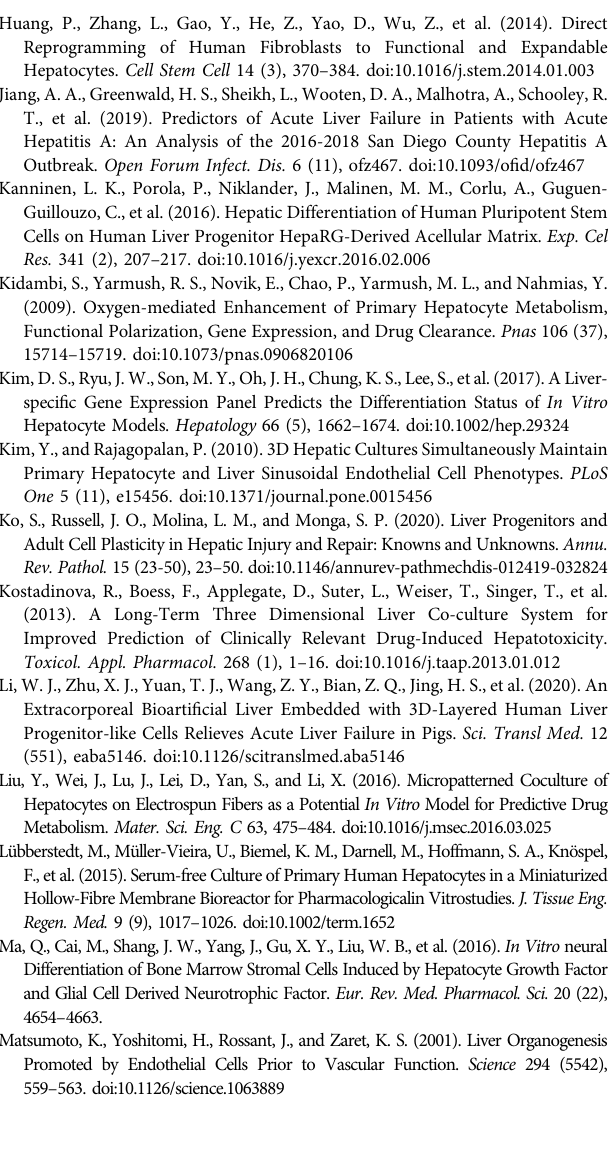
Supplementary Figure S1 | The safety and ef fi cacy of HepLPCs expressing HSV-TK. (A) GCV had a signi fi cant inhibitory effect on HepLPCs. Data are normalized to the DMSO group. (B) Cells appeared died after GCV treatment. (C) The Calcein-AM/PI assay was performed after GCV treated for 48h. (D) The PI positive cells were calculated from three independent experiments. Data are normalized to the DMSO group. (E) Cells were inoculated subcutaneously in immunode fi cient mice, n (cid:2) 5. (F) The cell viability (GFP positive cells) was calculated from three independent experiments. Data are normalized to the DMSO group. (G) The TUNEL assay was performed after GCV treatment. (H) The apoptotic cells (TUNEL staining positive cells) were calculated from three independent experiments. Data are normalized to the DMSO group. Data are represented as means ± SEM. * p < 0.05 and ** p < 0.01. Scale bars: 100 μ m. Supplementary Figure S2 | vHepLPCs had a higher cell viability than HepLPC spheroids. (A) Assessment of cell viability using Calcein-AM/PI staining. (B) qRT- PCR analysis of the expression of AFP. Data are normalized to the HepLPC group. Data are represented as means ± SEM. * p < 0.05. Scale bar, 100 μ m. Supplementary Figure S3 | HUVECs played an important role in co-culture system. (A) Bright- fi eld images of HepLPCs in different culture conditions. (B) qRT-PCR analysis of hepatic markers in different culture conditions. Data are normalized to the HepLPC group. Data are represented as means ± SEM. * p < 0.05 and ** p < 0.01. Scale bar, 100 µm.